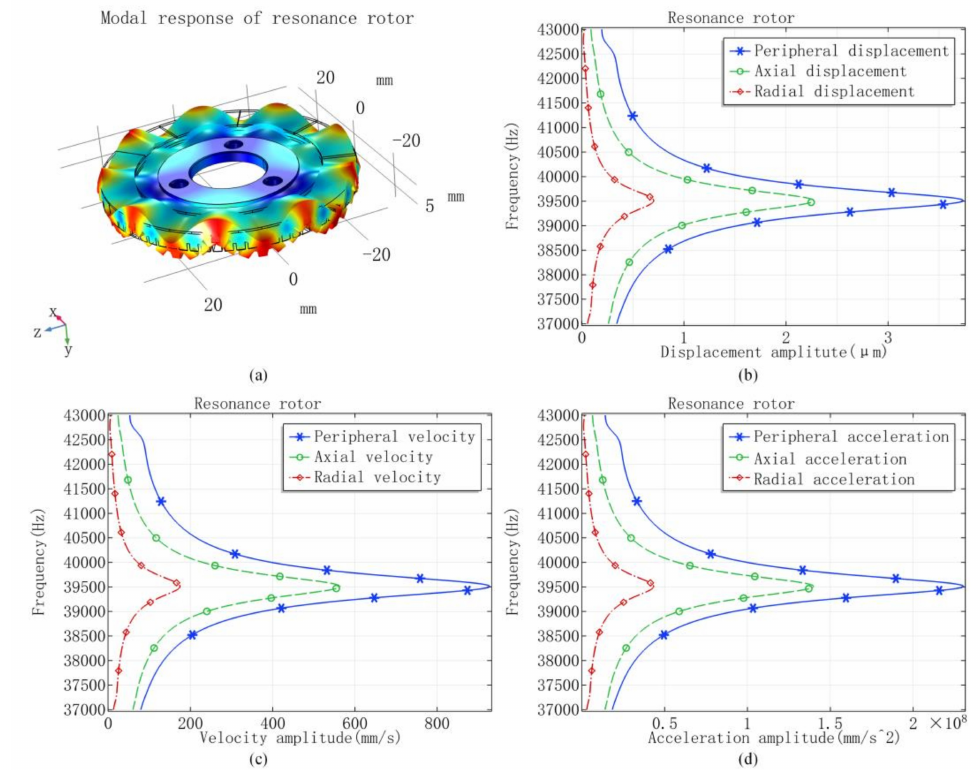
Figure 3. Amplitude response of resonance rotor in the peripheral, axial and radial directions. ( a ) Modal response nephogram of resonance rotor. ( b ) Displacement amplitude versus sweeping drive frequency. ( c ) Velocity amplitude versus sweeping drive frequency. ( d ) Acceleration amplitude versus sweeping drive